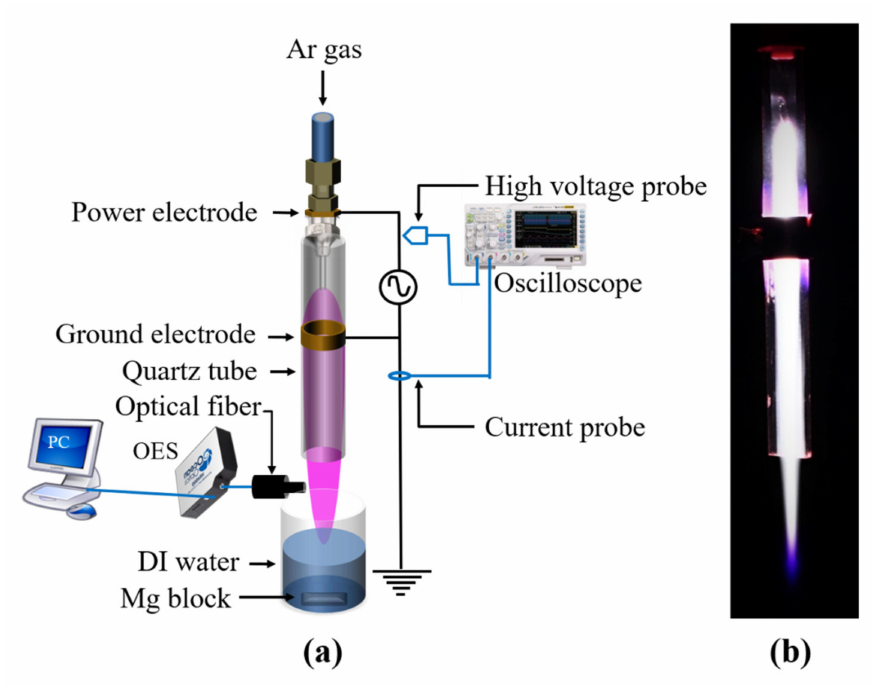
Figure 8. ( a ) Experimental setup of our atmospheric-pressure argon plasma jet system and ( b ) photo- graph of plasma plume. In ( a ), the plasma plume is